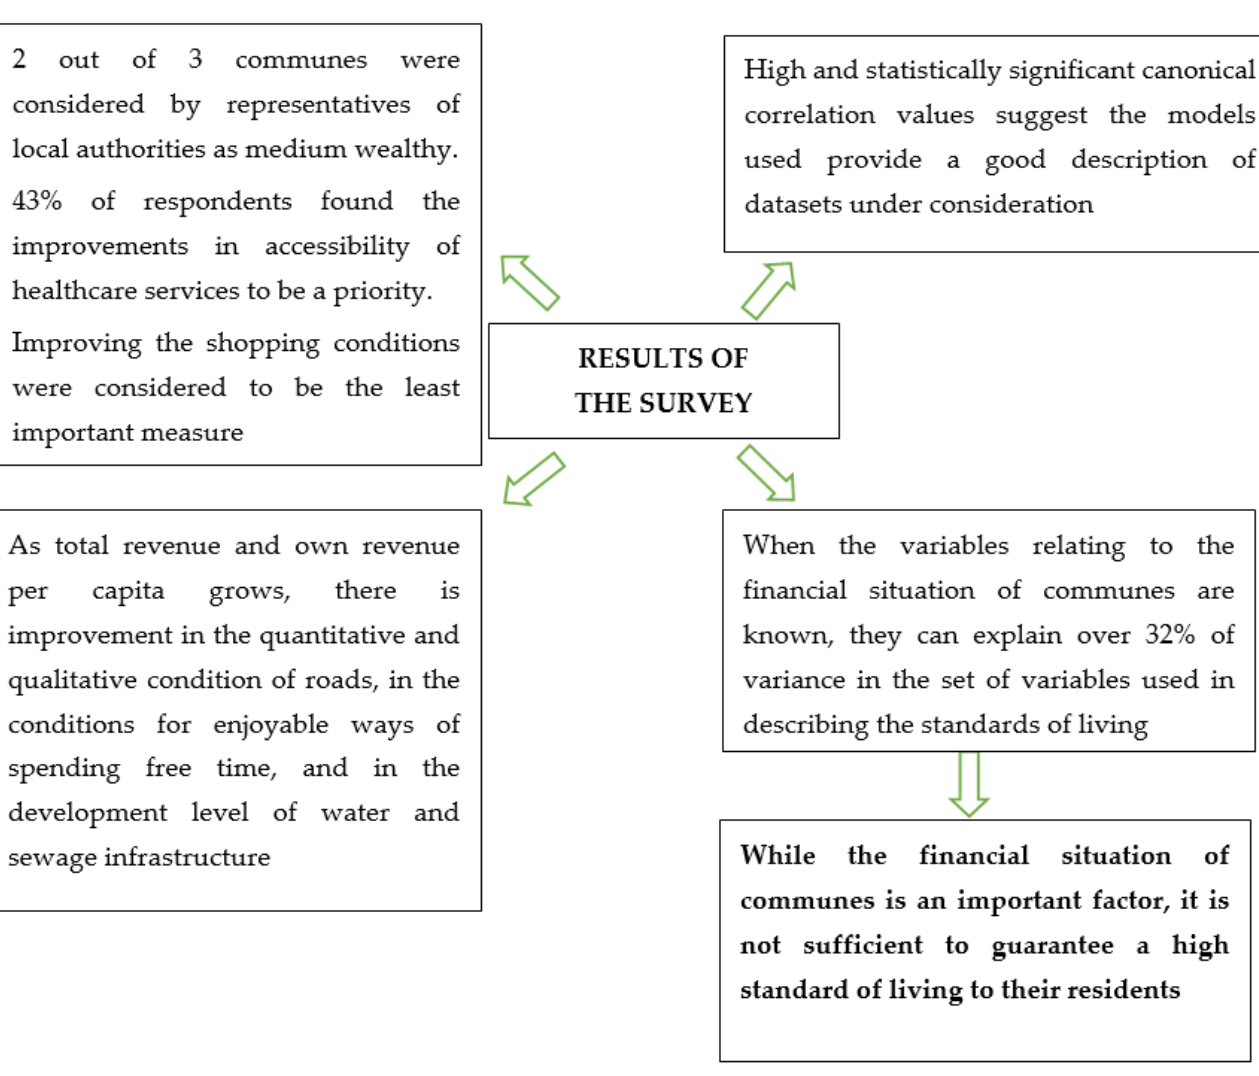
Figure 2. Synthetic summary of research results.